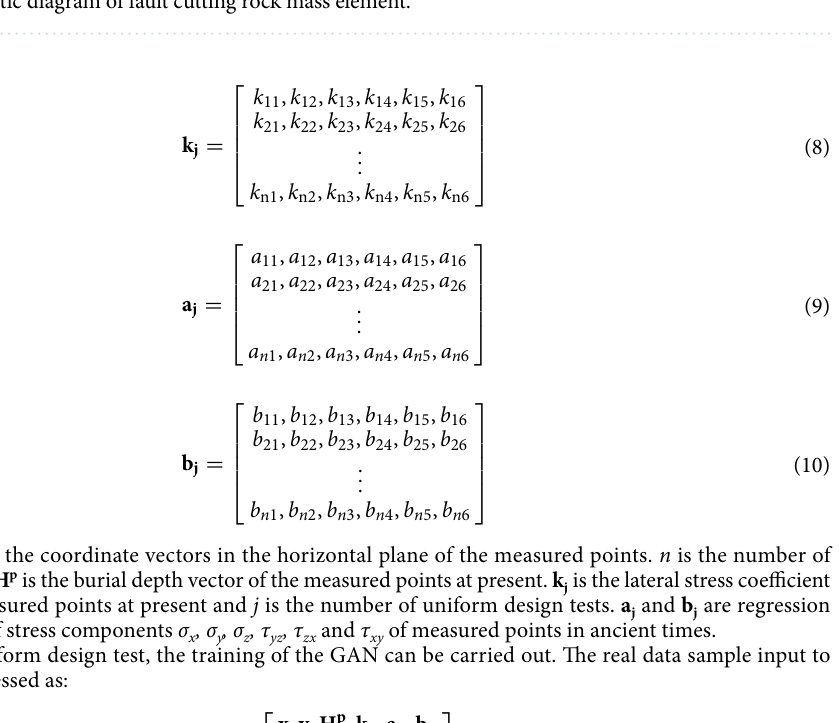
Figure 3. Schematic diagram of fault cutting rock mass